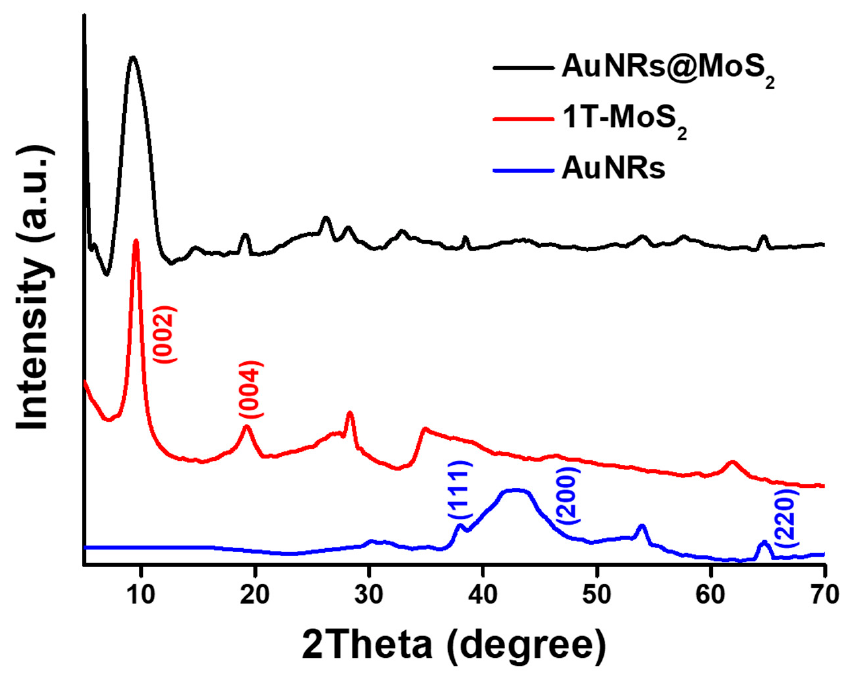
Figure 4. XRD spectra of gold nanorods (AuNRs), metallic molybdenum disulfide (1T-MoS 2 ) nanosheets (NSs), and MoS 2 @AuNRs.